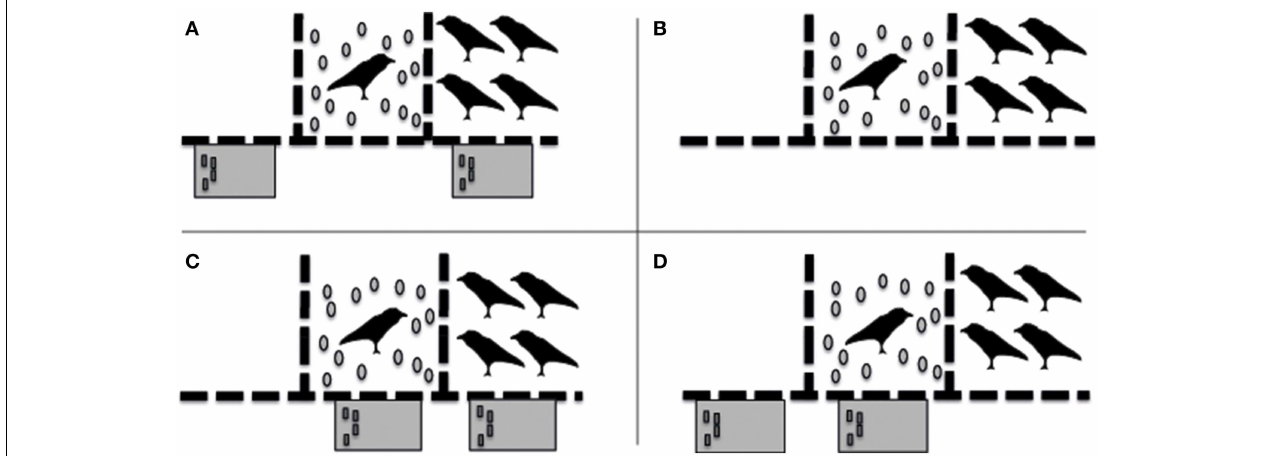
FIGURE 2 | Schematic representation of the different conditions in which the birds were tested in experiment 2: (A) Test condition; (B) Social Control condition; (C) “Costly Prosociality” Test condition; (D) “Costly Prosociality” Control condition.